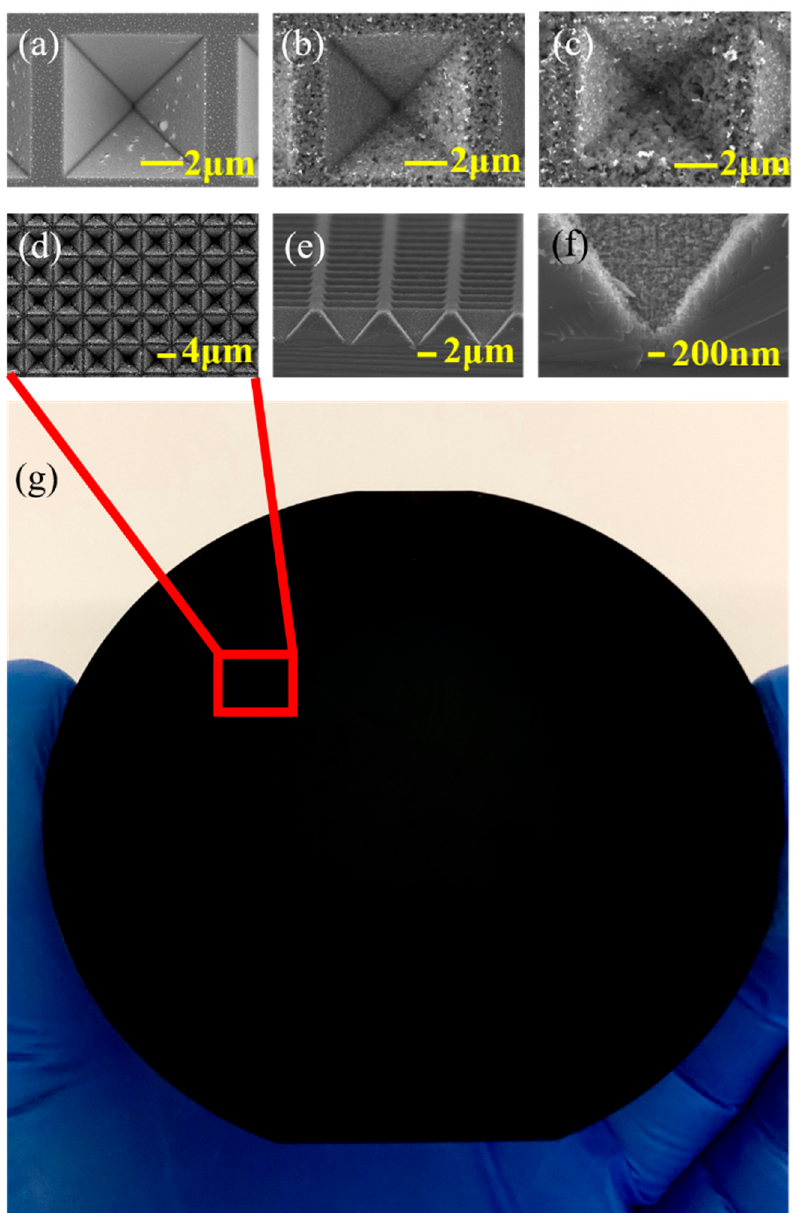
Figure 5. SEM images of inverted pyramids with period of 8 μ m treated by the MacEtch processes for ( a ) 3 min; ( b ) 8 min; ( c ) 10 min; SEM micrographs of ( d ) top view; ( e ) side view; ( f ) enlarged view of inverted pyramids with period of 8 μ m treated by the MacEtch processes for 8 min; ( g ) wafer-level fabrication of inverted silicon pyramidal arrays with randomly distributed nanoholes with a high wafer yield of Si anti-reflectivity coating.